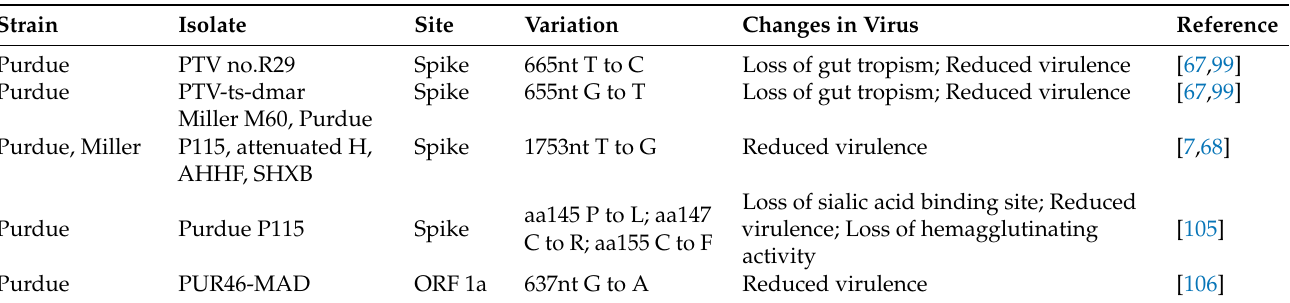
Table 2. Effect of point mutations on viral virulence and